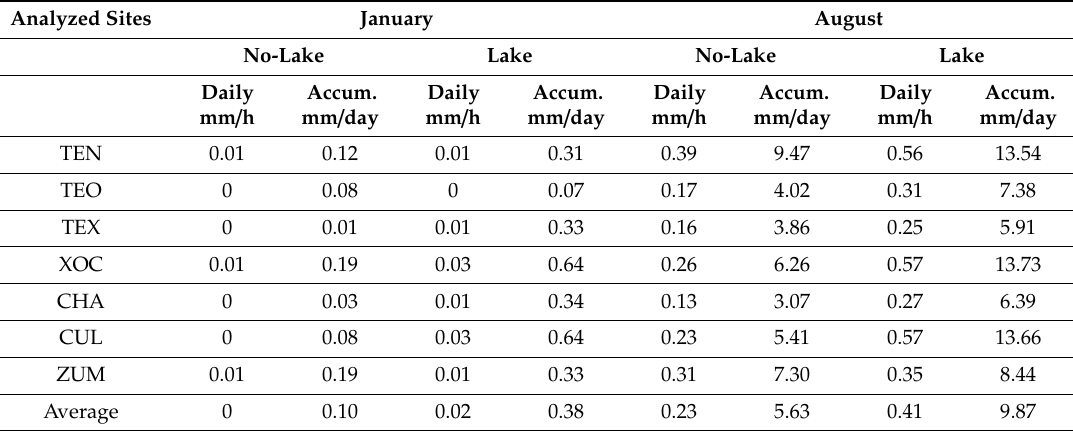
Table 1. Mean hourly precipitations and mean daily accumulated precipitations for January and August for all of the analyzed sites (see Figure 1 for the location of the sites): Teotihuacan (TEO), Tenochtitlan (TEN), Texcoco (TEX), Xochimilco (XOC), Chalco (CHA), Culhuac á n (CUL), and Zumpango (ZUM). All experiments used the WRF-Lake